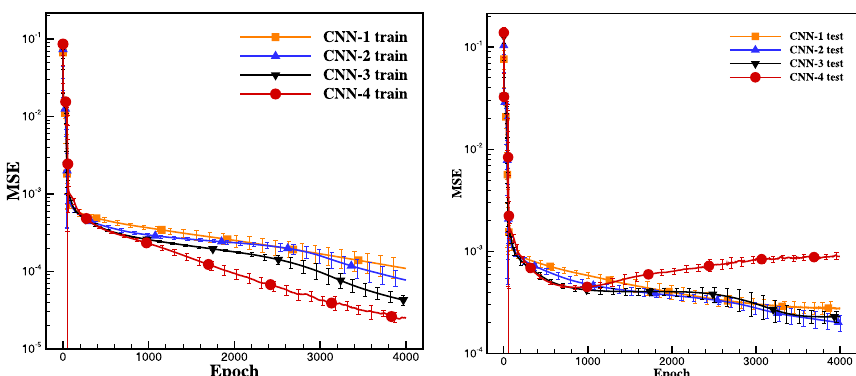
Fig. 14 MSE convergence histories of CNN‑1, CNN‑2, CNN‑3, and CNN‑4 in training dataset (left) and test dataset (right)